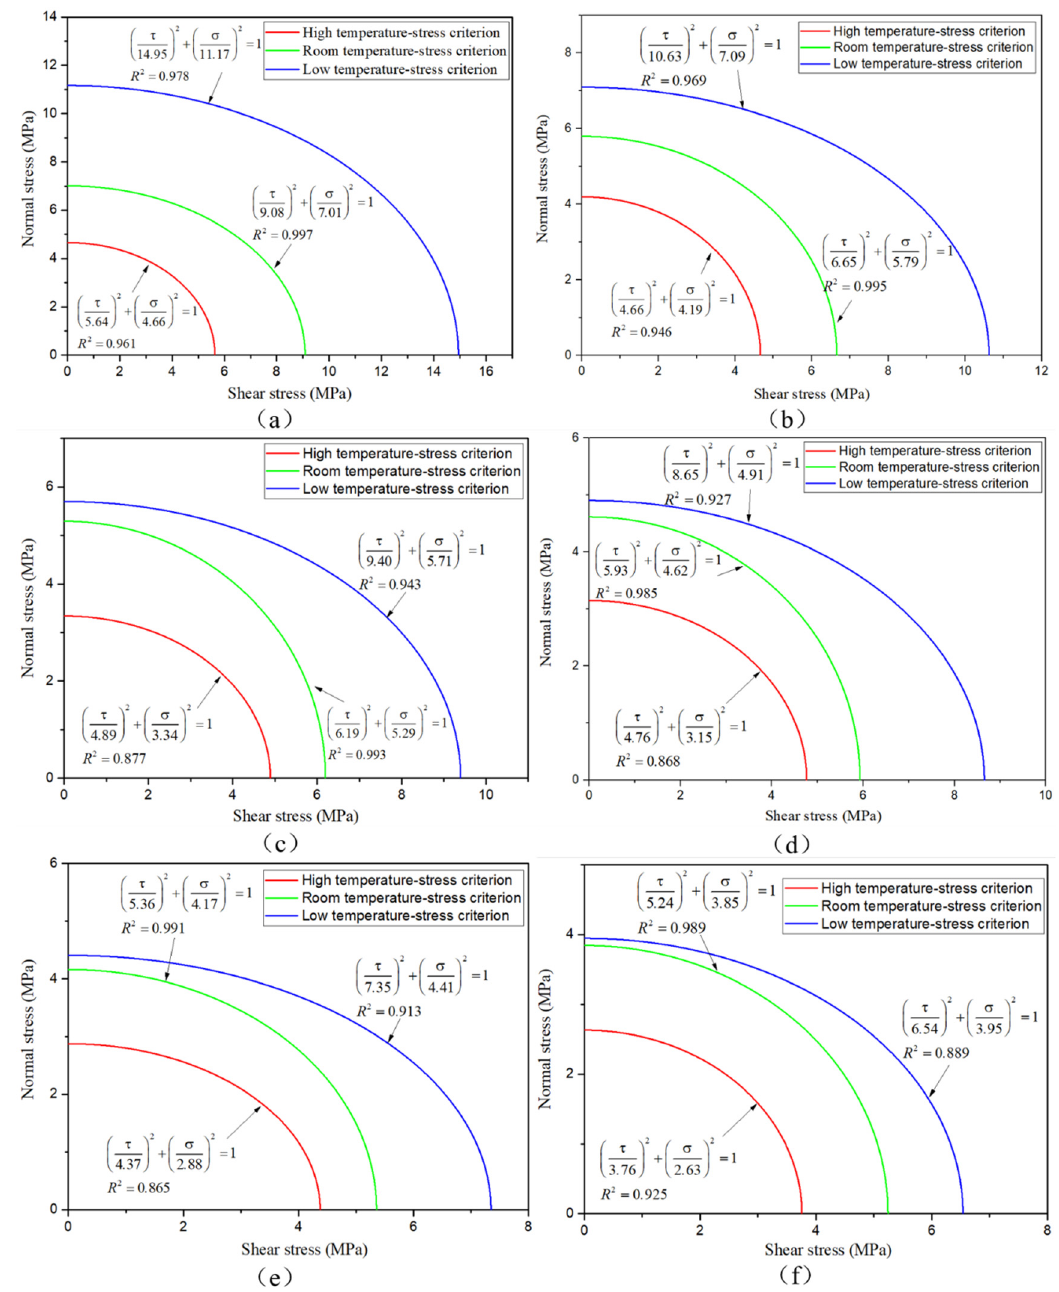
Figure 17. Secondary stress criterion fitting curves: ( a ) unaged; after aging for ( b ) 6, ( c ) 12, ( d ) 18, ( e ) 24, ( f ) 30 days. To evaluate the failure of the adhesive structure after the hygrothermal aging in the application of high-speed trains, the failure criteria of the adhesive joints with different aging periods need to be established by fitting the relationship between the failure criteria and the aging time. Based on the above analysis of failure criteria after 0 (unaged), 6, 12, 18, 24, and 30 days aged, all conform to the secondary stress criterion. It is assumed that the failure criteria of any aging time in 0–30 days are in accordance with the secondary stress criterion. The failure strength values in mode I and mode II are extracted from Fig- ure 17, and their functional relationship with the aging period is fitted. The failure strength and aging time are fitted by selecting the quadratic polynomial, cubic polyno- mial, and exponential function, as shown in Figure 18. It is found that the fitting accuracy